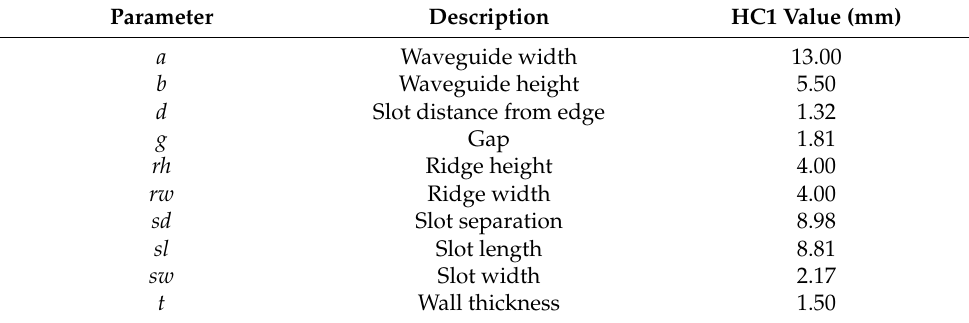
Table 1. Hybrid coupler 1 (HC1) geometrical parameters.